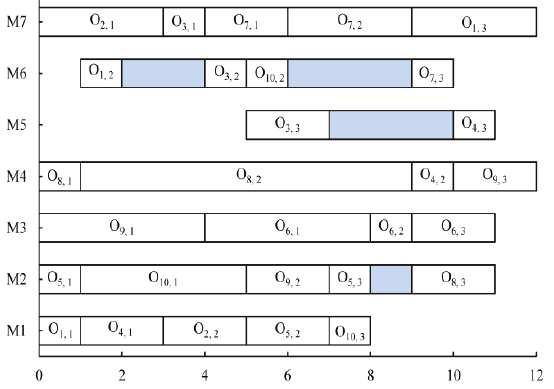
Fig. 5 Optimal Solution for 10x7 instance ( f